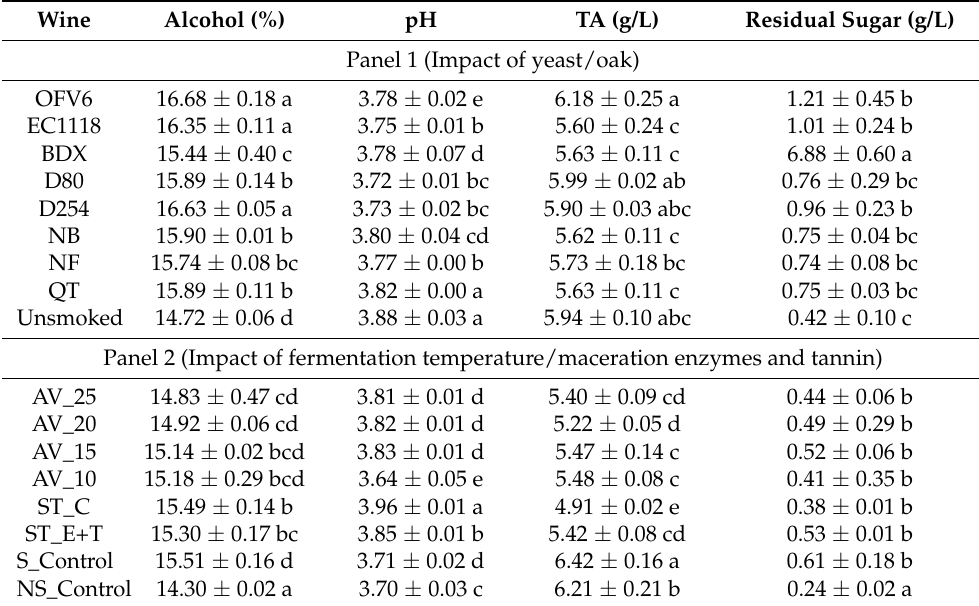
Table 1. Basic chemical composition of all wine treatments at bottling (n = 6; α =